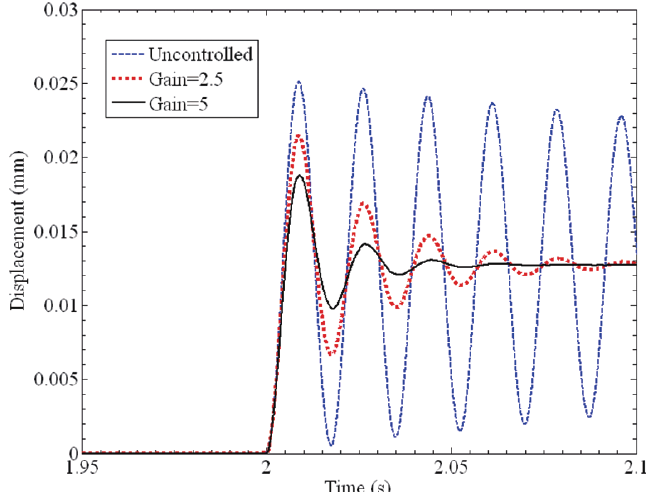
Fig. 9. Response of the uncontrolled and controlled system due to unit step excitation at t = 2 s.